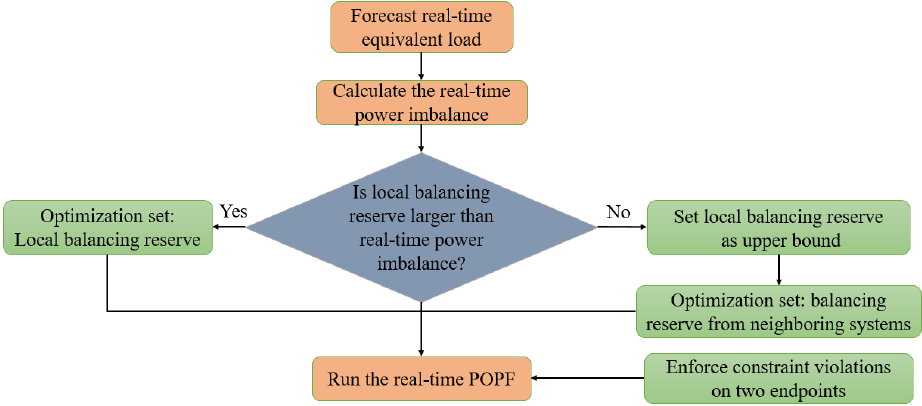
Figure 7. Real-time period optimal power flow